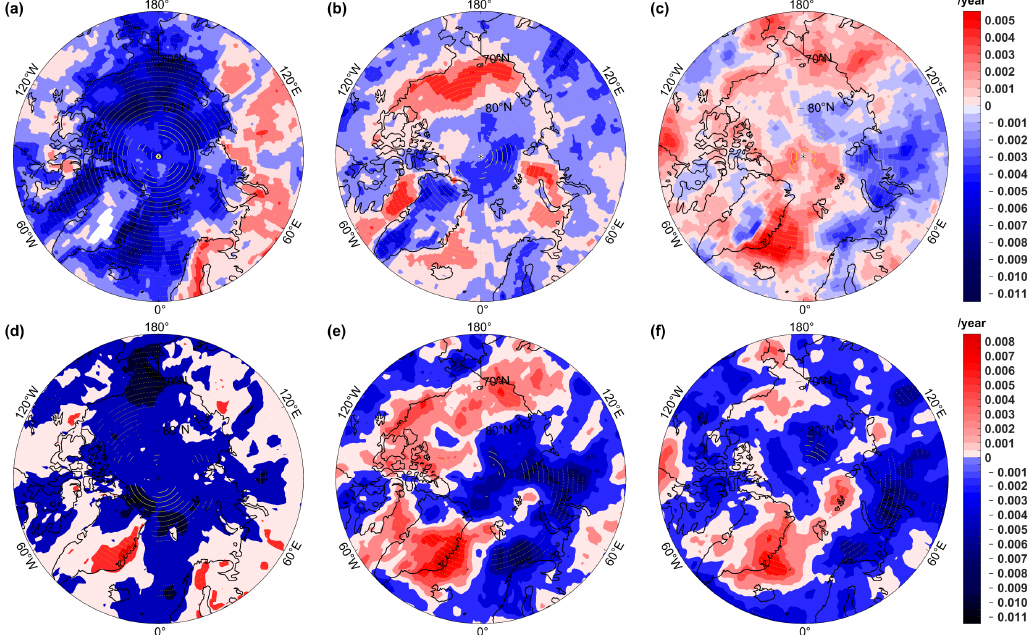
Figure 2. Trend of cloud fraction in autumn for ( a ) the low cloud (surface–700 hPa), ( b ) the mid-low cloud (700–500 hPa), and ( c ) the mid-high cloud (500–300 hPa) derived from the CERES data, and ( d ) the low cloud (1.0 > sigma > 0.8), ( e ) the mid-cloud (0.8 ≥ sigma > 0.45), and ( f ) the high cloud (0.45 ≥ sigma) derived from the ERA5 data. Both the CERES data and ERA5 data are for the period 2001–2017. The yellow dots denote statistical signi fi cance at the 95% level.